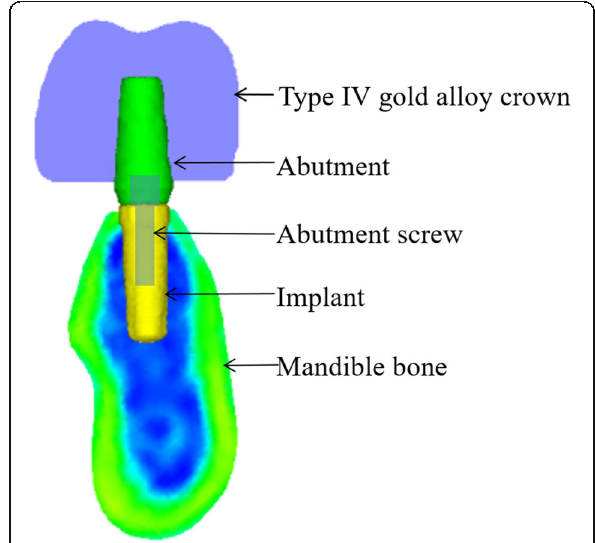
Fig. 4 3D finite element models